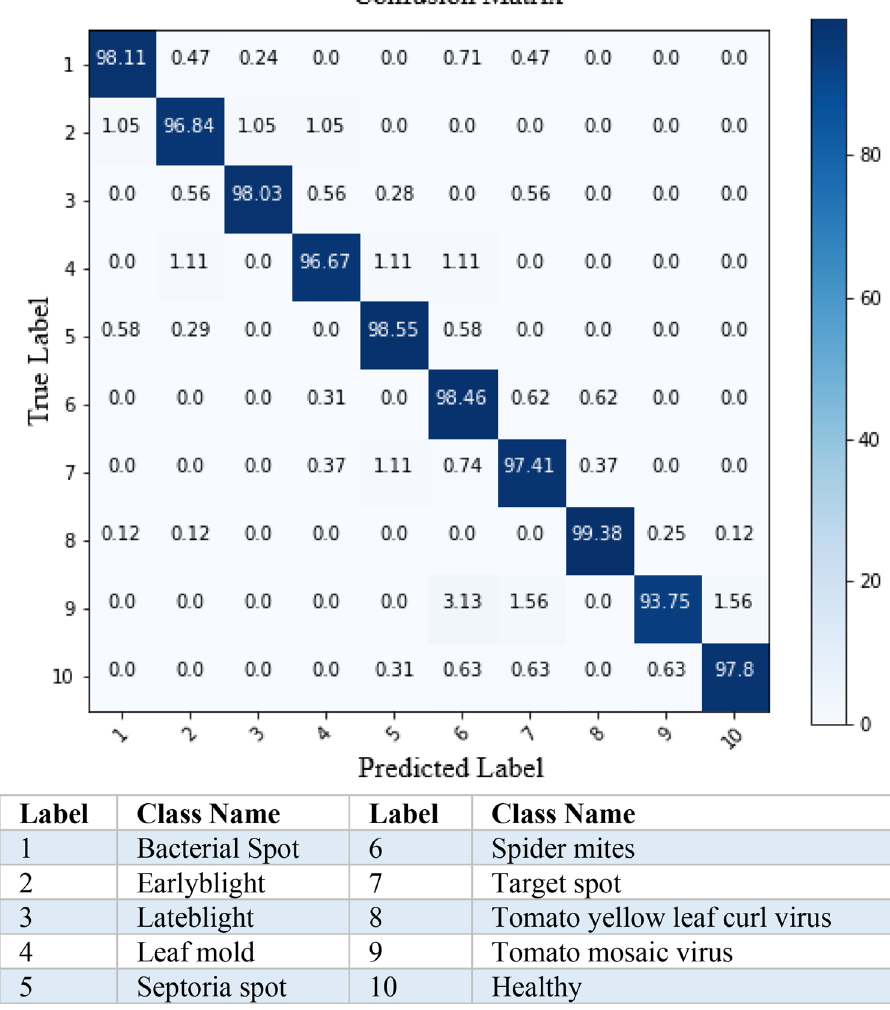
Fig. 6 Confusion matrix obtained for plant disease detection with the proposed